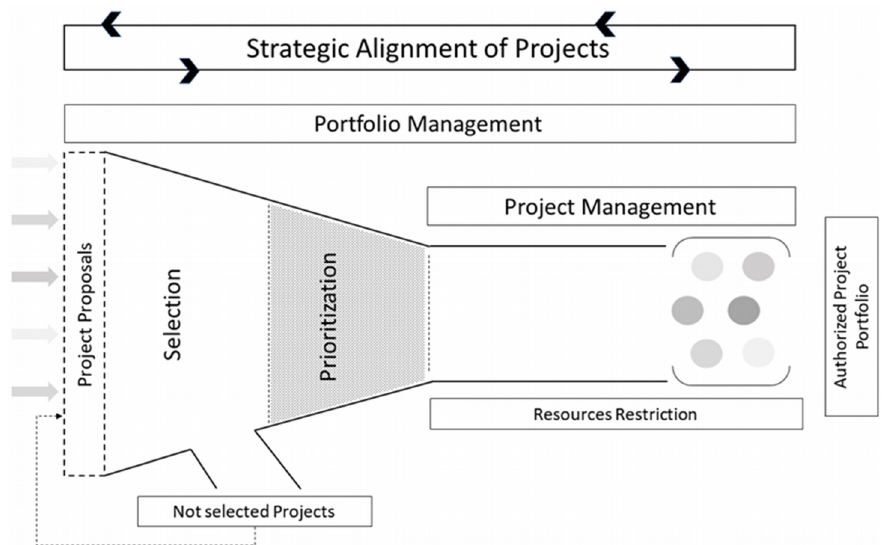
Figure 2. Portfolio management and its phases (Archer & Ghasemzadeh,